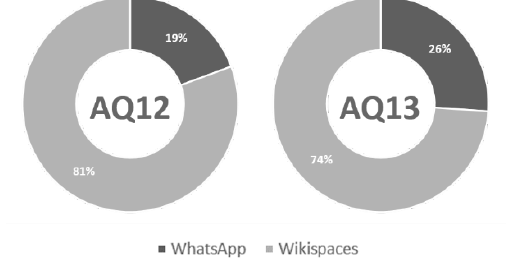
Fig 9. Artifact used by students to perform AQ12 and AQ13 Comparing the content produced by the students in the warm-ups, Table 1 shows the average number of characters in texts receive via WhatsApp was smaller than texts from Wikispace in both warm-ups, although this difference was statistically significant only in the AQ13. ( two-sample t(18) = 2,101, p = 0,006). This result suggests that writing on mobile devices influences the size of students’ texts, probably due to typing on virtual keyboards of smartphones be slower and more error-prone than on traditional computer keyboards [19].